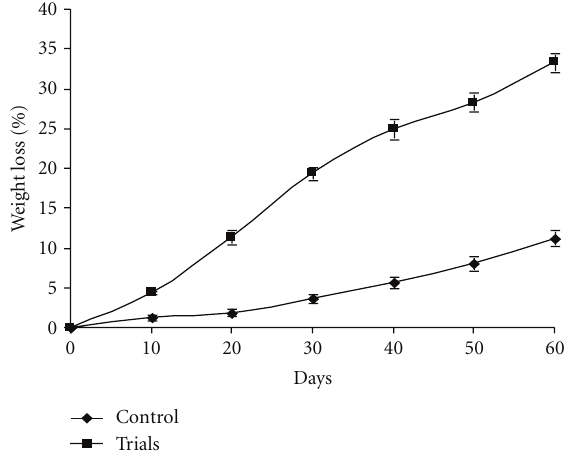
Figure 7: Percent weight loses of municipal solid waste by spore suspension of T. viride in open piles